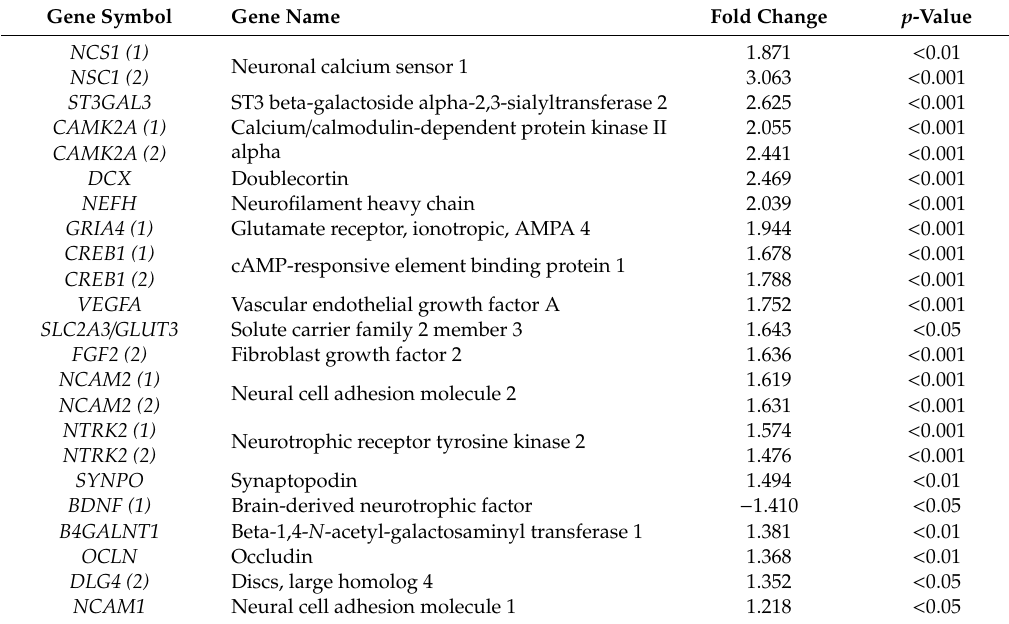
Table 4. Relative mRNA expression levels of selected genes for TERM-NAT. Values are scaled to TERM-CON set to 1. Numbers in brackets indicate primer number if several primers for same gene were